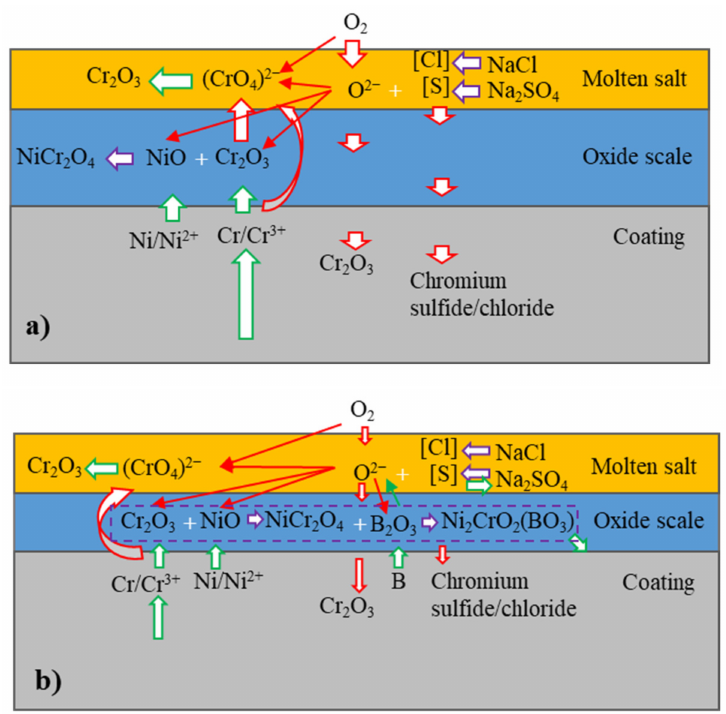
Figure 10. Schematic of hot corrosion mechanism of ( a ) NiCrTi coating and ( b ) NiCrB